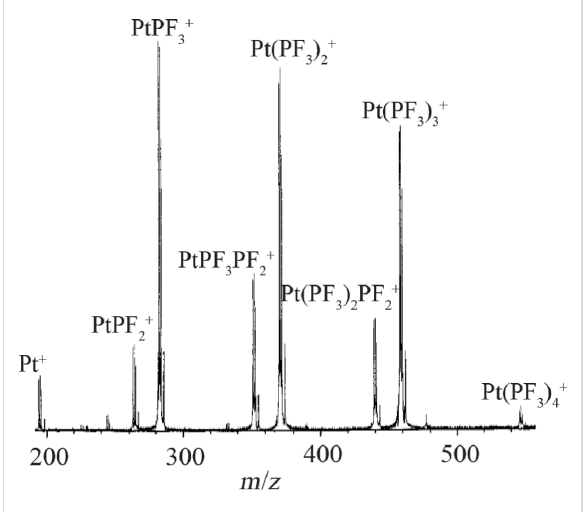
Figure 13: Electron ionization FT-ICR mass spectrum of Pt(PF 3 ) 4 recorded at 20 eV incident electron energy (reproduced with permis- sion from [22], Copyright (1997) American Chemical Society).